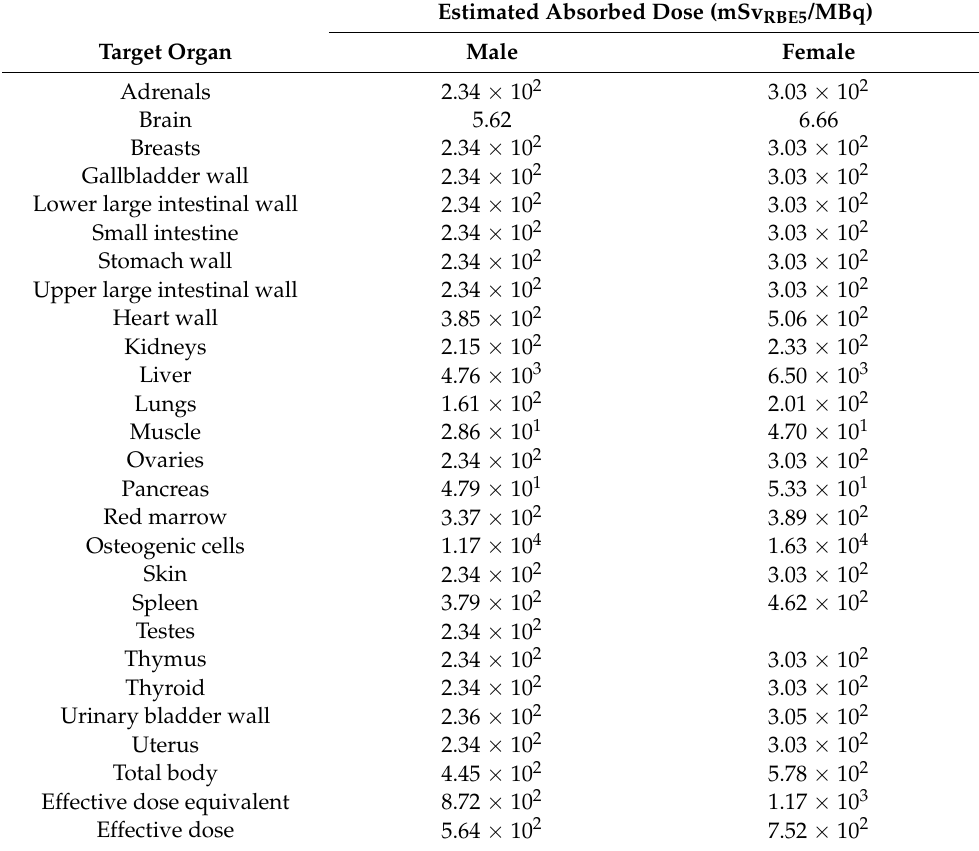
Table 2. Mean estimated human absorbed doses for free actinium-225 ( 225 Ac), extrapolated from mice biodistribution